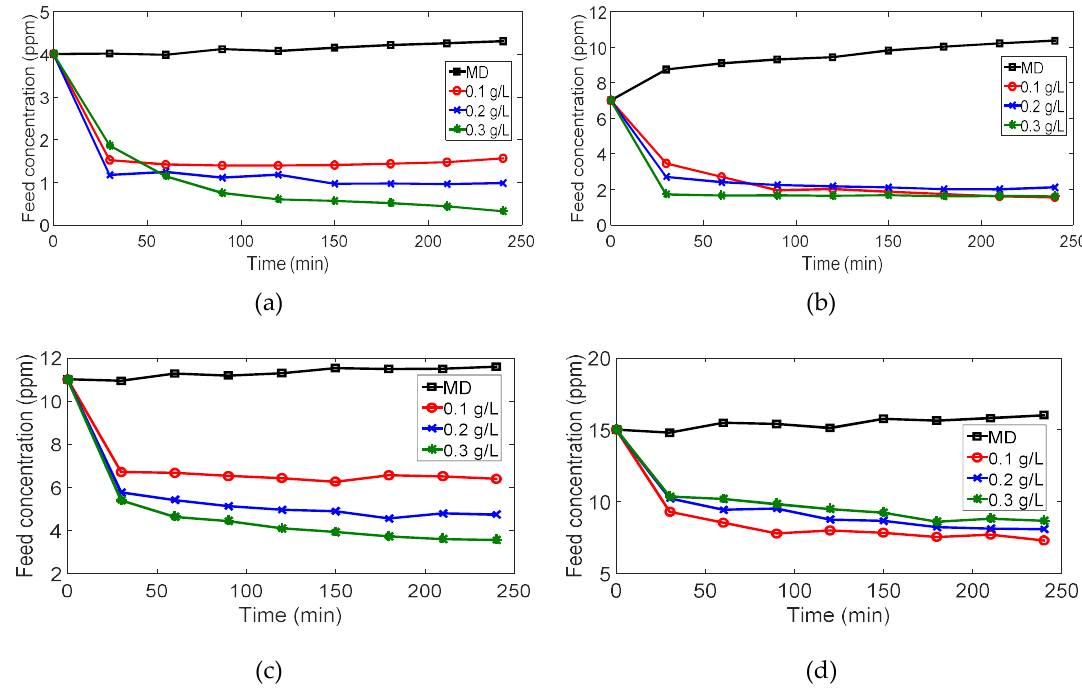
Figure 15 . Feed concentration vs. time: ( a ) 4 ppm; ( b ) 7 ppm; ( c ) 11 ppm; ( d ) 15 ppm. Table 3. Summary—PMR and membrane distillation (MD) performance.